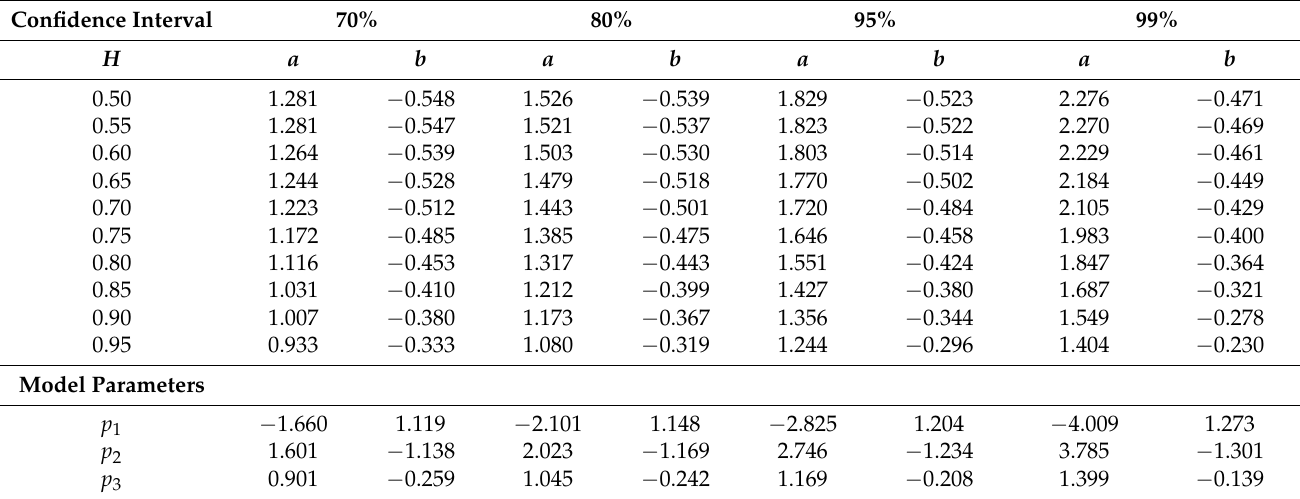
Table 1. Model parameters a , b , p 1 , p 2 , p 3 for various confidence limits and Hurst